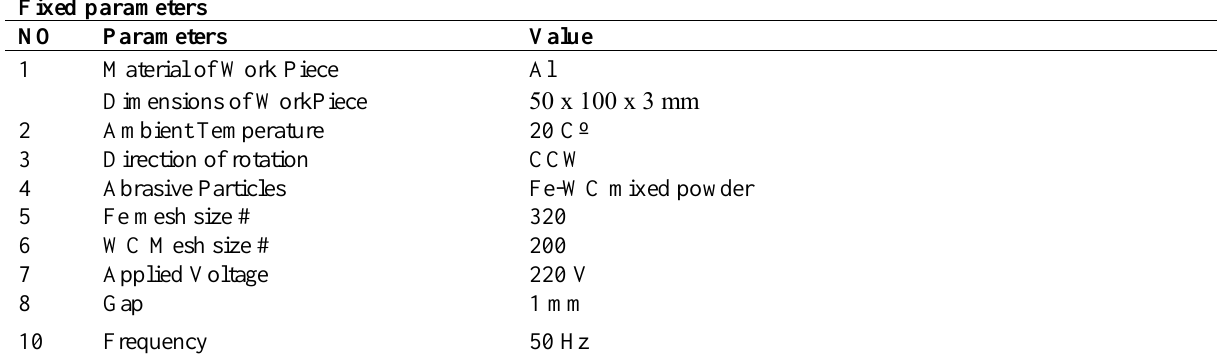
Fixed parameters